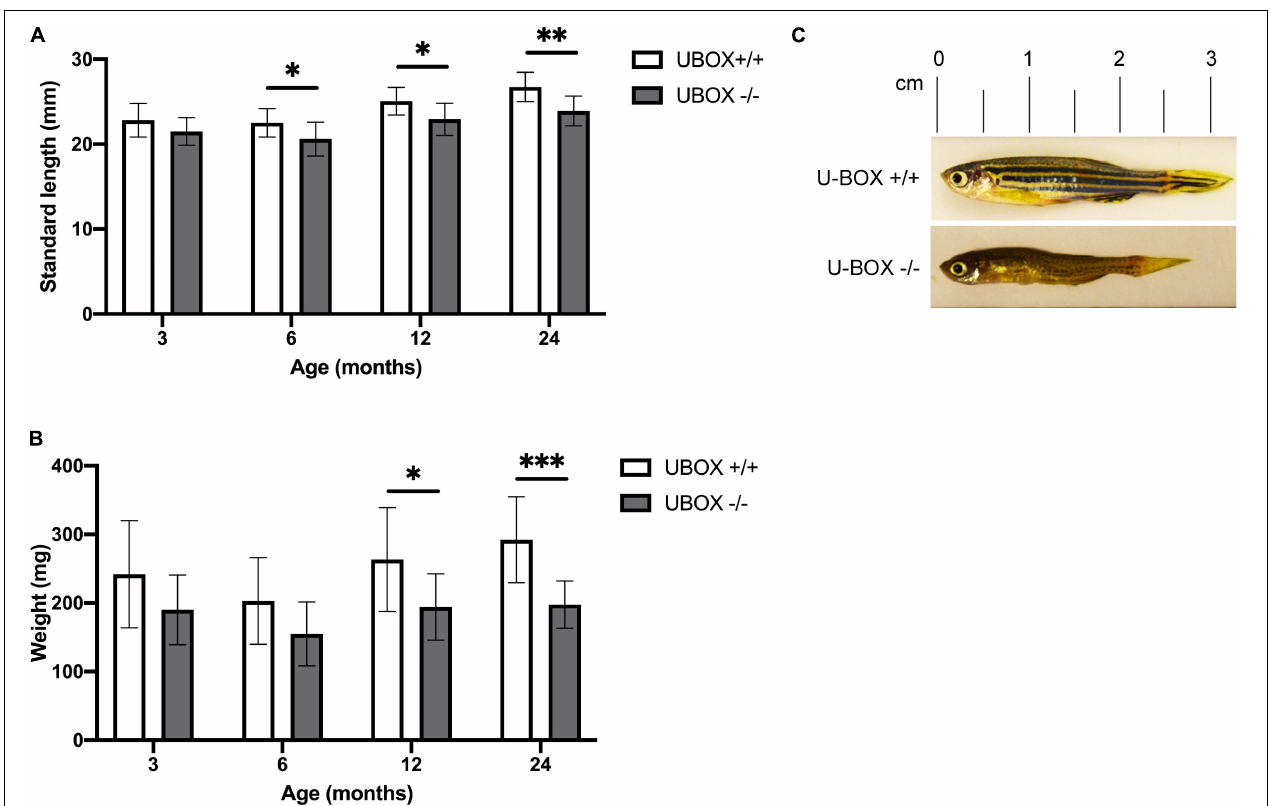
FIGURE 4 | U-box − / − fish are associated with smaller body size compared to their wild-type siblings. Quantification of standard length (A) and body weight (B) are presented for wild-type and U-box − / − zebrafish in indicated age groups ( n = 10). Data shown are means and error bars indicate standard deviation. Statistically significant differences are shown by asterisks ( ∗ p < 0.05; ∗∗ p < 0.01; ∗∗∗ p < 0.001, Student’s t -test). (C) Representative images of U-box − / − and wild-type zebrafish (female) at 24 months of